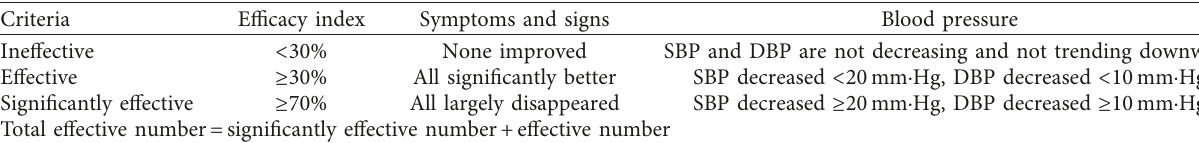
Table 2: Criteria for determining efficacy.